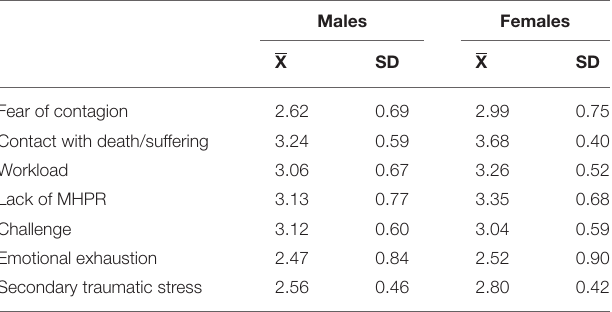
TABLE 6 | Descriptive information per variable concerning gender: males ( n = 47) and females ( n = 174). Males Females